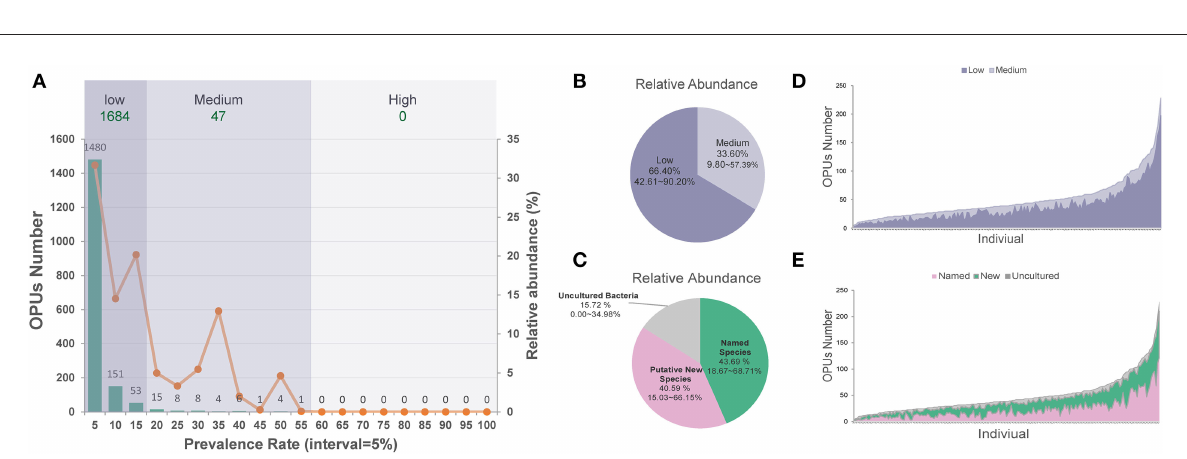
FIGURE2 The distribution of low and medium prevalent 1,731 OPUs in the healthy eyes. (A) The prevalence and relative abundance of OPUs in ocular surface microbiota the numbers (left axis) and the relative abundance (right axis) of the OPUs in individuals with the 5% interval. (B) The relative abundance of OPUs in low and medium prevalent group. (C) The relative abundance of OPUs of named species, potential new species, and high-level taxa. (D) The number of OPUs in low and medium prevalence groups in 196 eyes. (E) The number of OPUs of named, potential species, and high-level taxa in 196